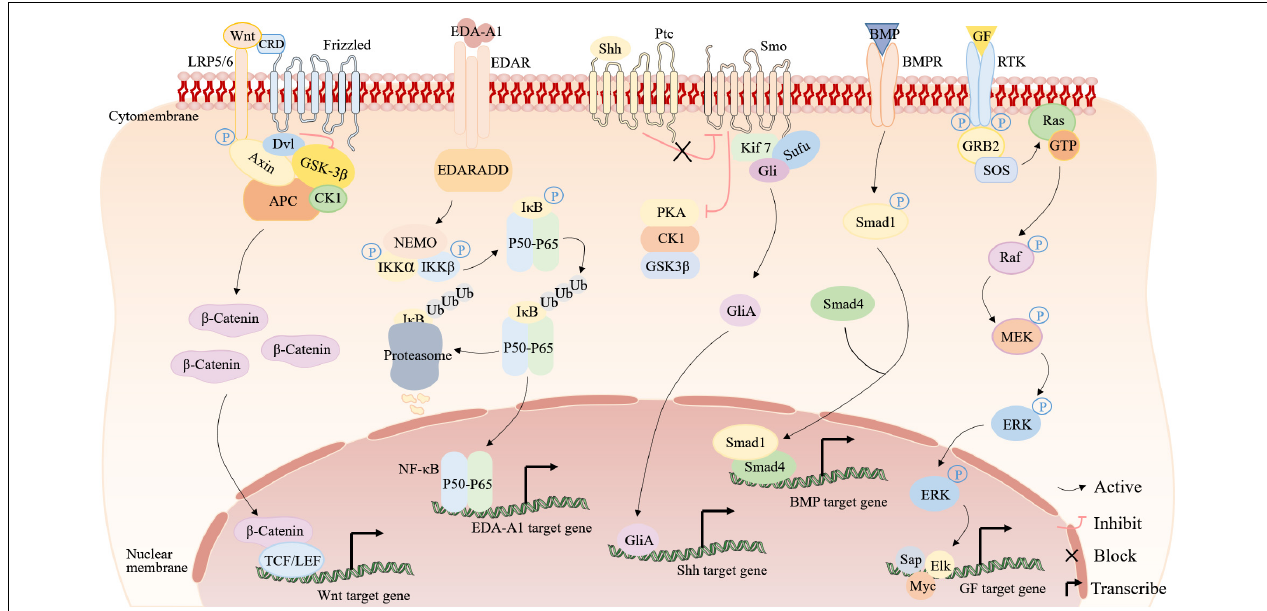
FIGURE 4 | The signaling pathways involved in ESG development and regeneration. From left to right are the Wnt, EDA-A1, Shh, BMP, and ERK signaling pathways. Wnt signaling pathway (Nusse and Clevers, 2017; Routledge and Scholpp, 2019): in the absence of Wnt signals, GSK-3 β /Axin/APC/ β -catenin/CK1 is a destruction complex. GSK-3 β phosphorylates β -catenin, thereby inhibiting its activity and then β -catenin is degraded by ubiquitination. When Wnt proteins bind to a receptor complex, it induces the association of Axin and Dvl with LRP5/6 and Frizzled. Dvl inhibits GSK-3 β and the destruction complex falls apart, and thus prevents the degradation of β -catenin, permitting β -catenin accumulation, leading to binding TCF/LEF in the nucleus to upregulate target genes. EDA signaling pathway (Oeckinghaus et al., 2011; Sisto et al., 2016): in the absence of EDA-A1 signals, NF- κ B dimers (P50–P65) are bound to inhibitory I κ B proteins, which sequester inactive NF- κ B complexes in the cytoplasm. When EDA-A1 binds to EDAR, stimulation of EDAR leads to the binding of EDARADD, for IKK activation. Shh signaling pathway (Fattahi et al., 2018; Xin et al., 2018): in the absence of Shh signals, Ptc inhibits the activity of Smo by affecting its localization to the cell surface, and protein kinases (PKA, CK1, and GSK3 β ) constitutively phosphorylate Gli proteins to inhibit the Gli. The secreted active Shh ligand binds to Ptc and relieves the repressive effect of the Ptc on Smo, activating the Smo, which then translocates to the cell membrane to inhibit PKA, CK1, and GSK3, providing an assembly platform for the recruitment of Kif7, Sufu and Gli, thus activating the Gli. Subsequently, the activated Gli forms (GliAs) translocate into the nucleus and activate Shh target genes. BMP signaling pathway (Gonzalez and Medici, 2014): when BMPs bind to BMPRs, intracellular Smad1 becomes phosphorylated. The phosphorylated Smad1 binds to Smad4 and then translocates into the nucleus and activates BMP target genes. ERK signaling pathway (Calvo et al., 2010; Gallo et al., 2019): Phosphorylated RTK binds to GRB2, and GRB2 binds to SOS, which stimulates RAS. RAS initiates activation of the MEK-ERK cascade by converting a molecule from GDP to